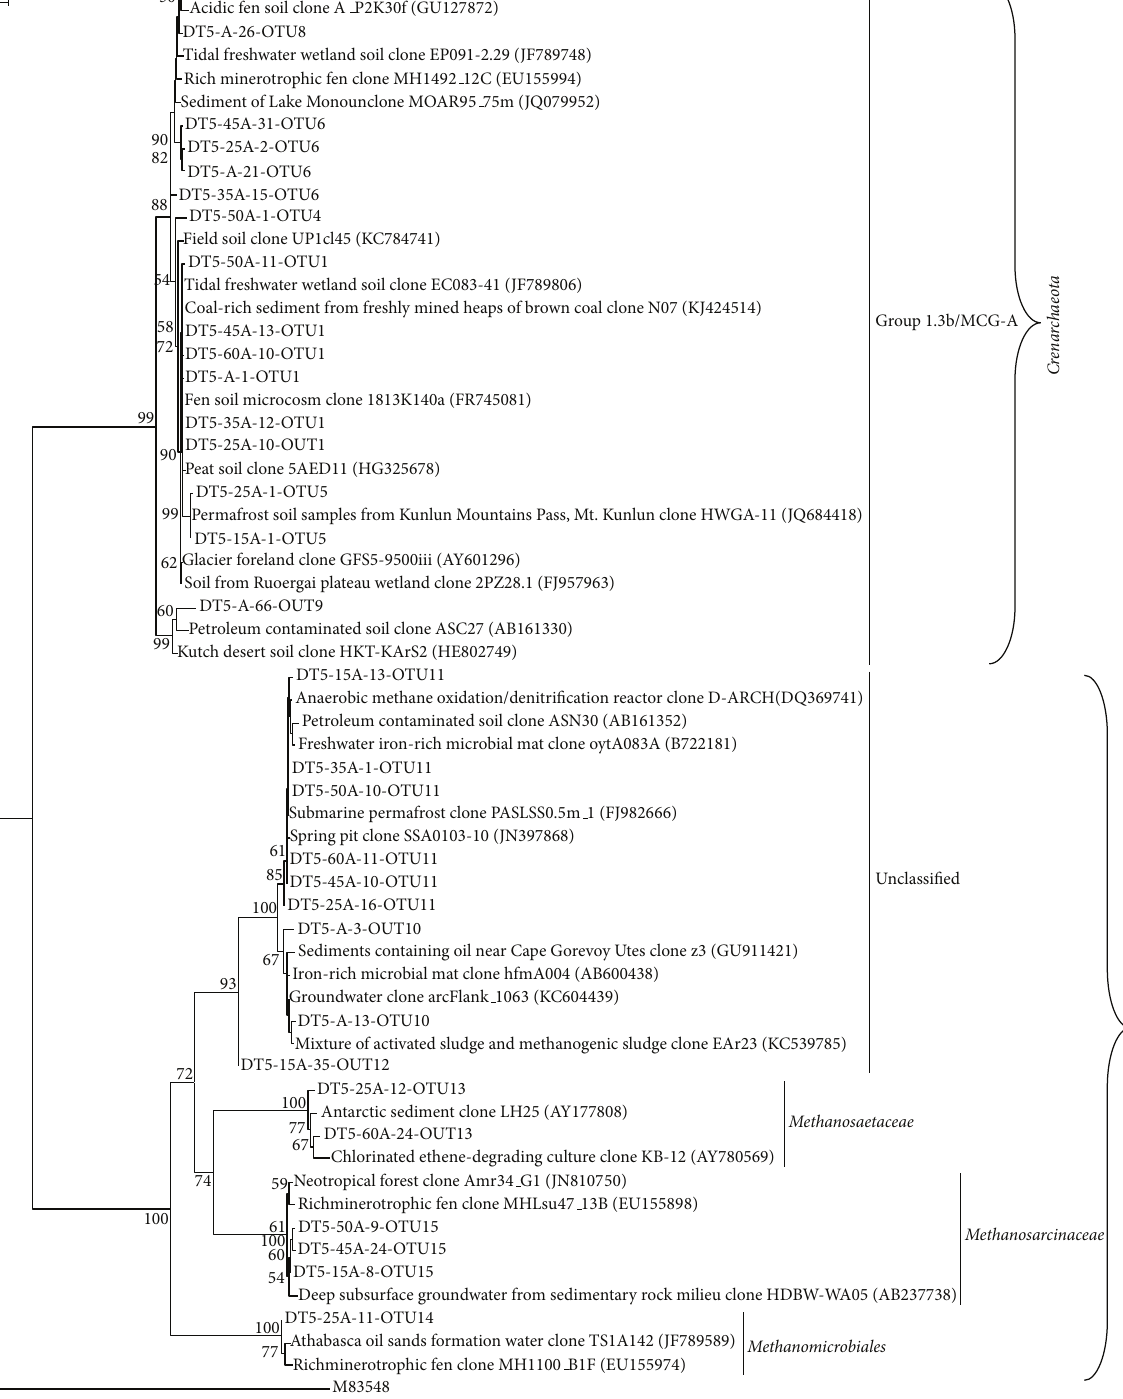
Figure 1: Phylogenetic tree of archaeal 16S rRNA gene sequences from the stratigraphic soil profile. The tree was constructed using the neighbor-joining method from a similarity matrix based on the distance determined by Kimura’s two-parameter model. Bootstrap values (100 replications) generated using the maximum parsimony method. The phylotypes were named according to the soil depth origin. Numbers in brackets were GenBank accession numbers. The scale bar represents 5% estimated